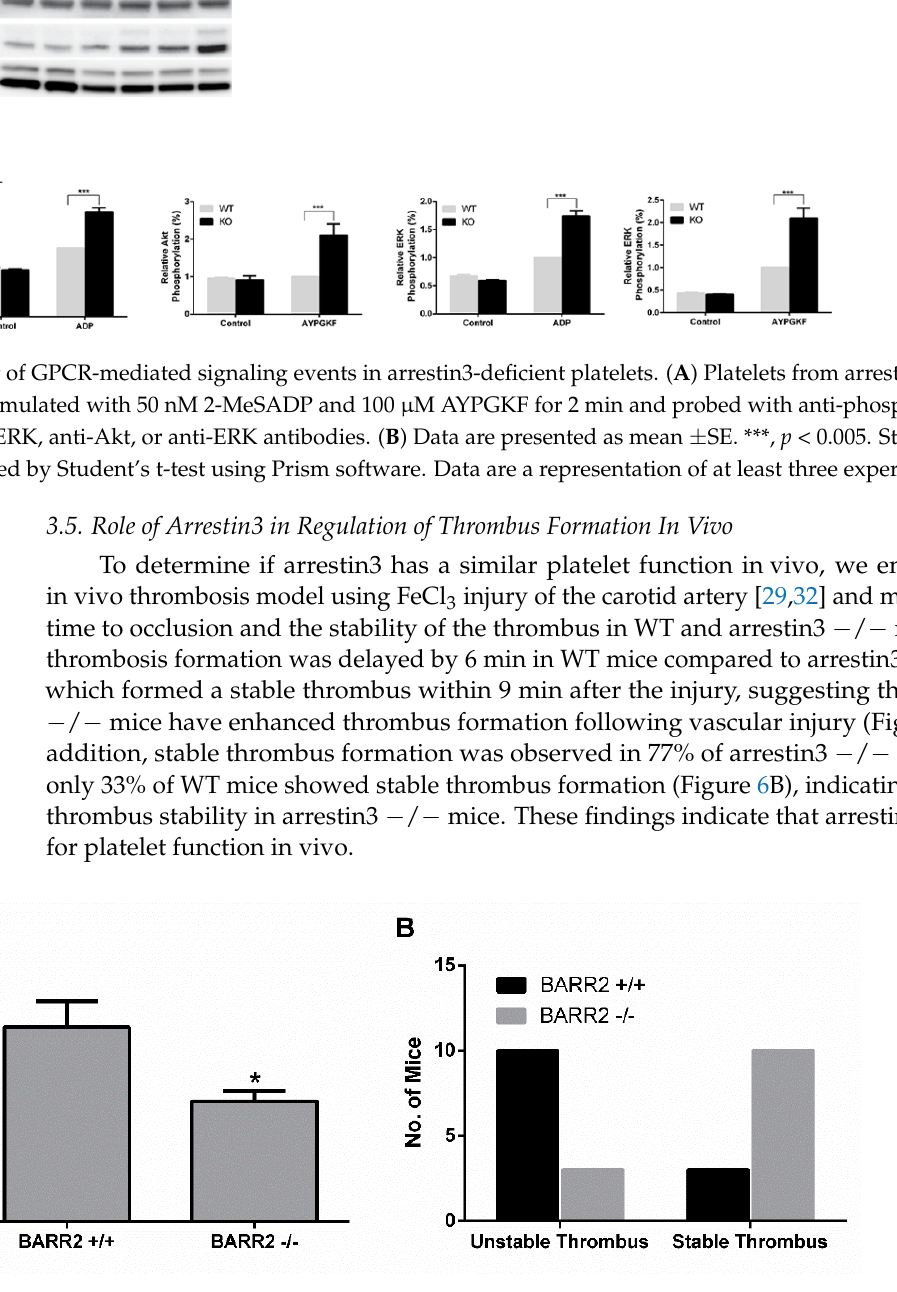
Figure 6. Effect of arrestin3 on enhanced thrombus formation in vivo. To damage the carotid arteries of WT ( n = 13) and arrestin3 − / − ( n = 13) mice, 5% FeCl 3 was used for 90 sec. Following vascular damage, flow rates via the carotid artery were recorded for 30 min with a Doppler flow probe. ( A ) Time to initial occlusion of the carotid artery in WT and arrestin3 − / − mice was recorded. Data are mean ± SE. *, p < 0.05. ( B ) Thrombus stability in the carotid artery of WT and arrestin3 − / − mice was determined by counting the number of mice with stable thrombi for at least 10 min.